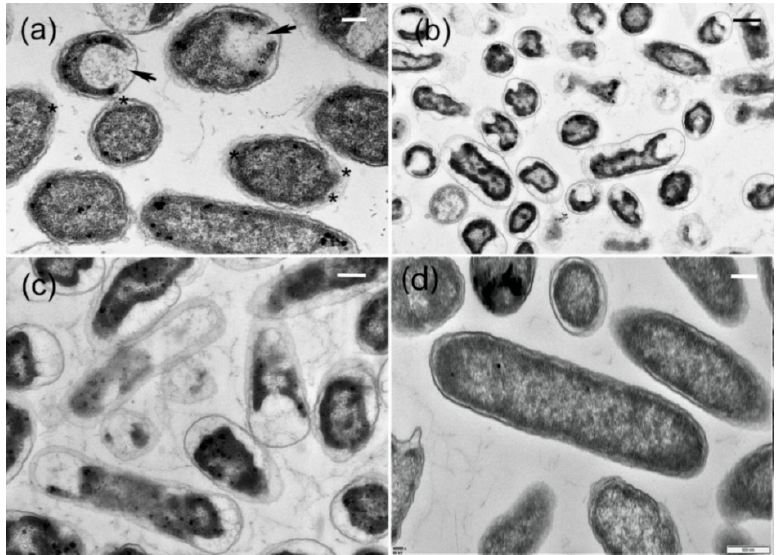
Figure 11. Ultrastructural characteristics of interaction of Ag-NPs with cells of R. solanacearum ; ( a ) interruption (*) of the local cell walls and partial degradation (arrows) of cytoplasmic membranes in some cells after treatment by AgCl-NPs ( b ) for 4 h; ( b , c ) treatment by AgCl-NPs for 8 h; ( b ) change of structural components of the cytoplasm in some cells; ( c ) change of cell walls and the cytoplasm in some cells; ( d ) treatment by CFCS extract (control) for 8 h.